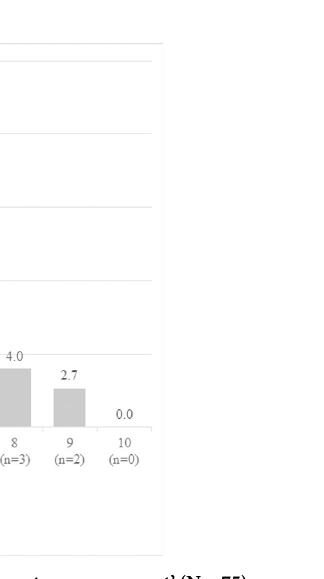
Fig 1. Frequencies for meeting the 10 quality criteria for ’good refrigerator management’ (N = 75).